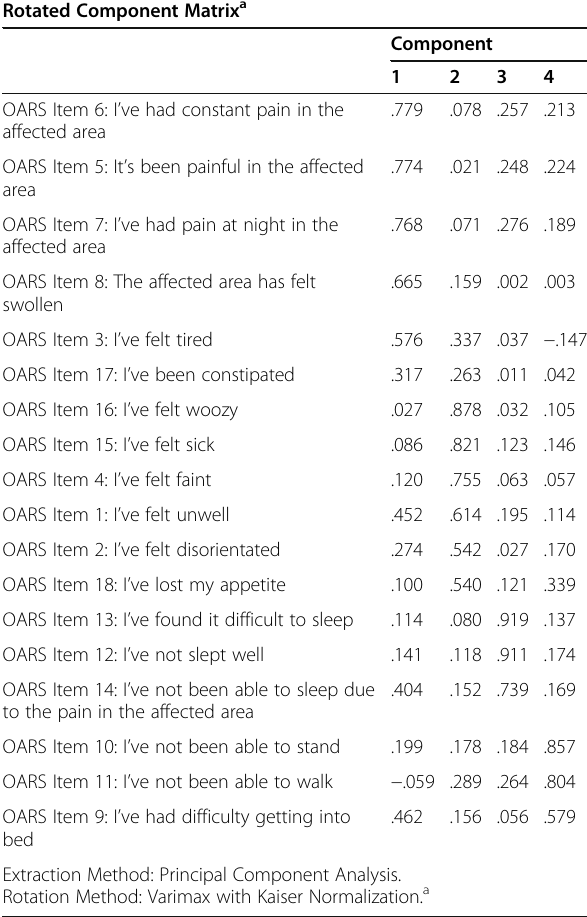
Table 6 Phase 3 18-item OARS day one item factor loadings Rotated Component Matrix